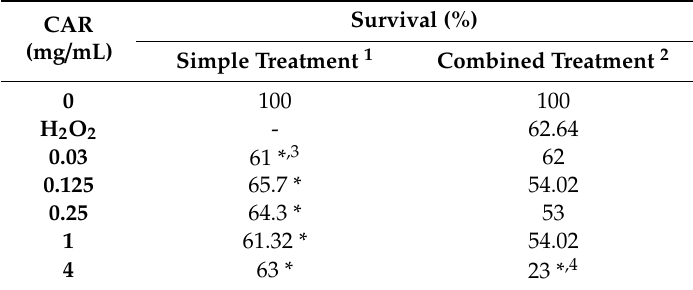
Table 2. Toxicity and antitoxicity levels of CAR in D. melanogaster .